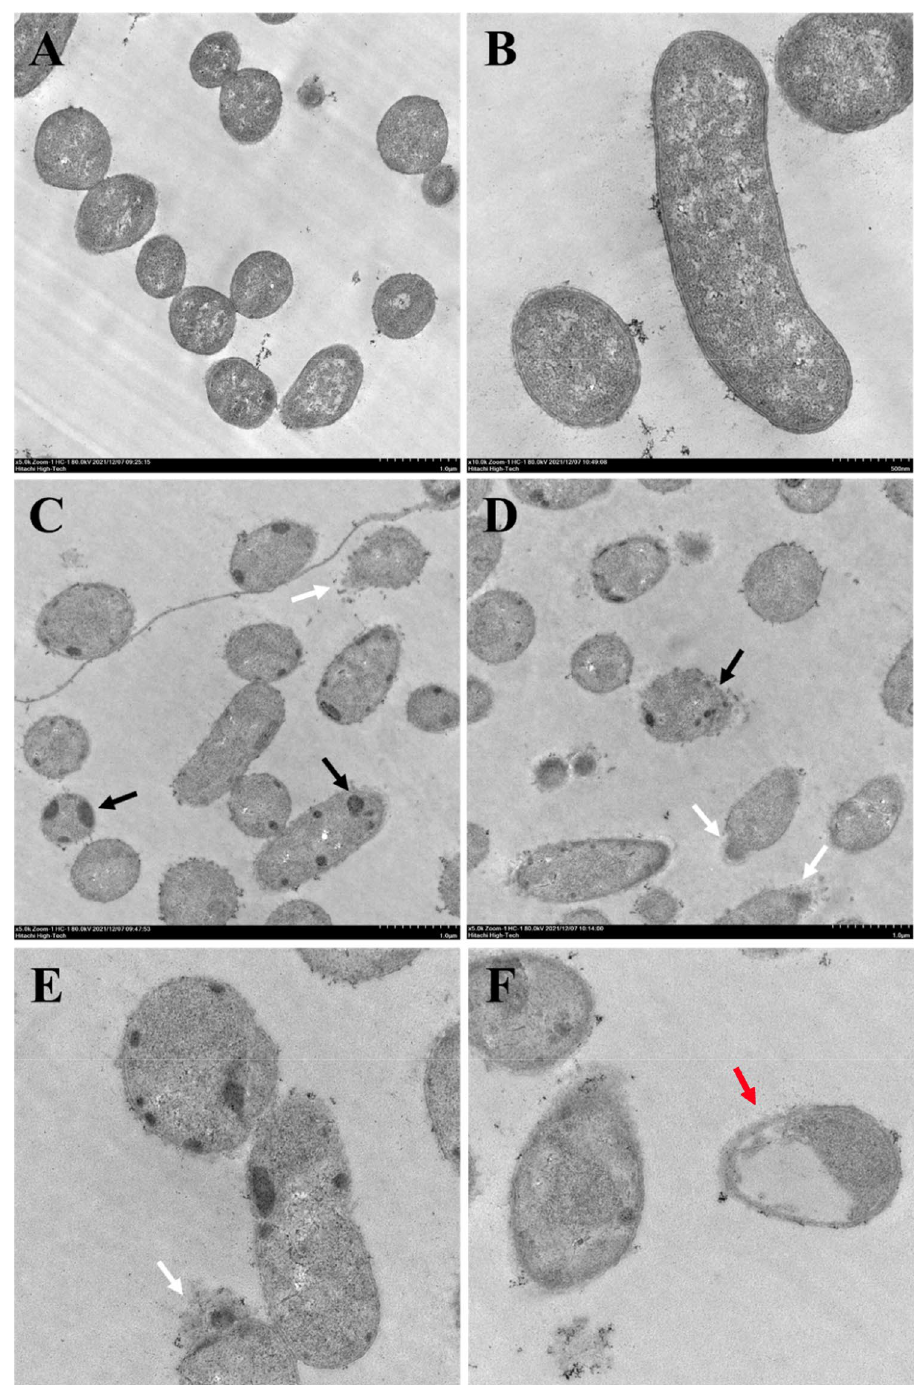
Figure 7. Transmission electron microscopic micrographs of A. baumannii ATCC 19,606 treated with D-AP19. Untreated bacterial cells ( A ), ( B ) and cells treated with half MIC of D-AP19 for 15 min ( C )–( F ). Black, white and red arrows indicate inclusion bodies, intracellular leakage and ghost cells in bacterial cells,